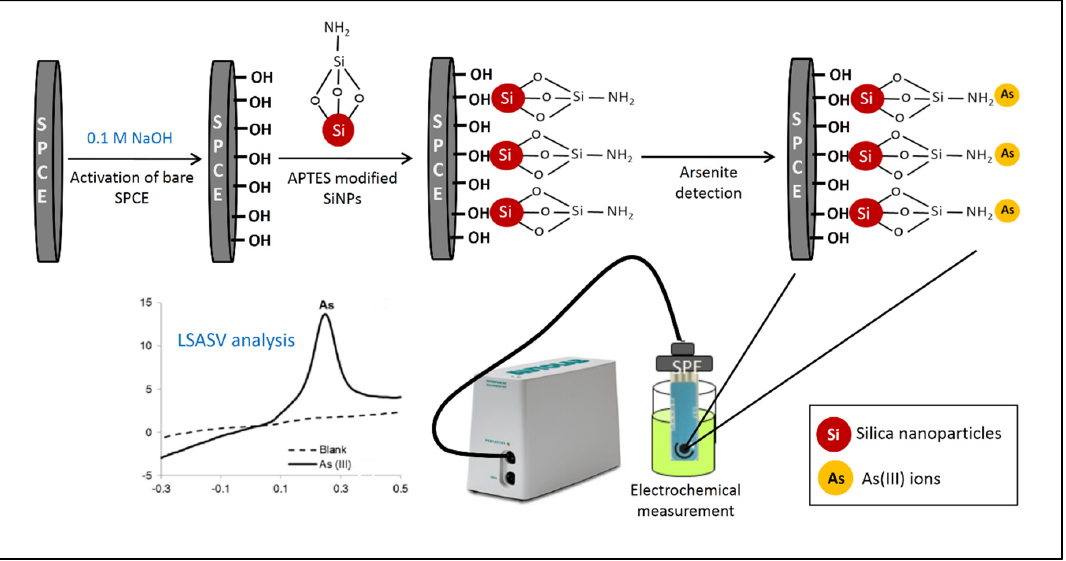
Figure 1. Schematic representation of the fabrication process of the silica nanoparticles (SiNPs)/screen ‐ printed carbon electrode (SPCE) electrochemical sensor.